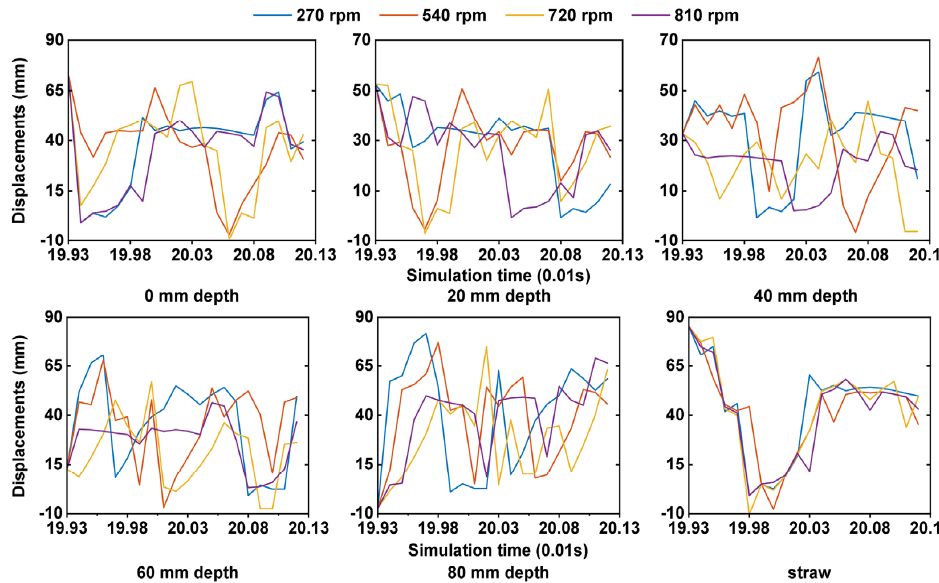
Figure 11. Vertical displacements of soil particles at di ff erent depths and surface straws at di ff erent rotary speeds.